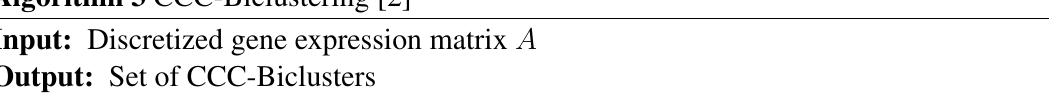
Figure 2: Maximal CCC-Biclusters in the discretized matrix and related nodes in the suffix tree. Algorithm 3 CCC-Biclustering